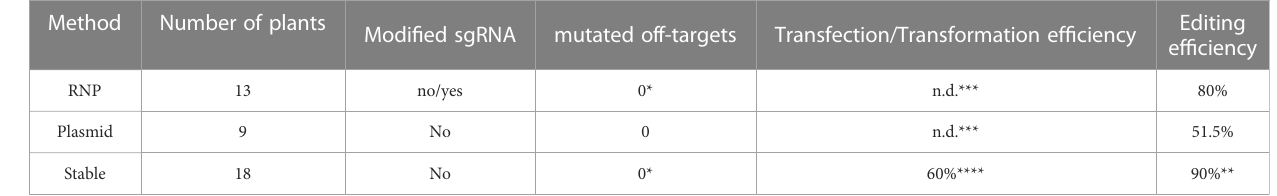
TABLE 4 Total number of plants analysed for at least six possible